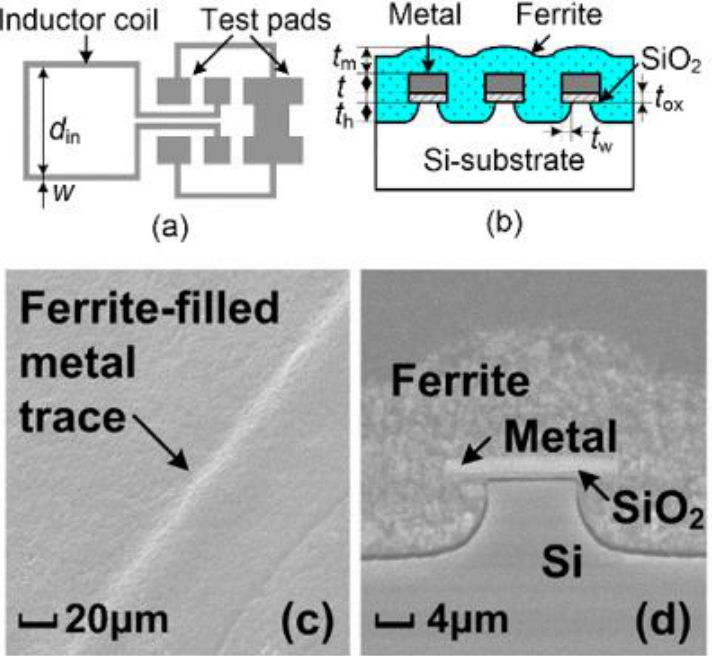
Figure 2. Prototype ferrite-partially-filled inductor fabricated: ( a ) device with GSG pads, ( b ) X-section, ( c ) Ni-Zn-Cu ferrite coating coil trace by SEM, and ( d ) X-section of Ni-Zn-Cu partially-filled metal trace by SEM [16].